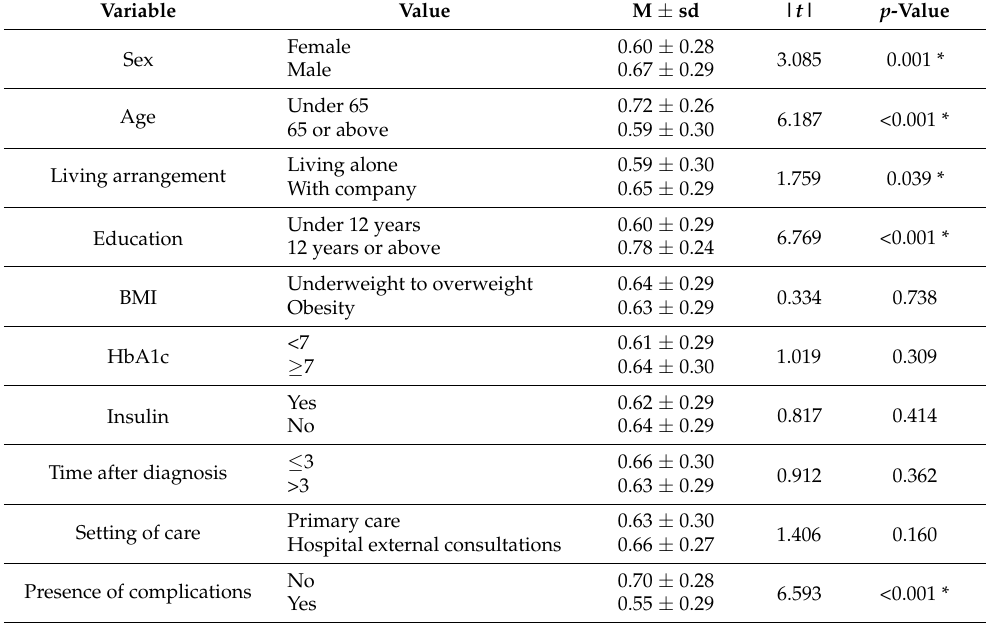
Table 3. Comparison of EQ-5D-5L scores across different sociodemographic and clinical groups.